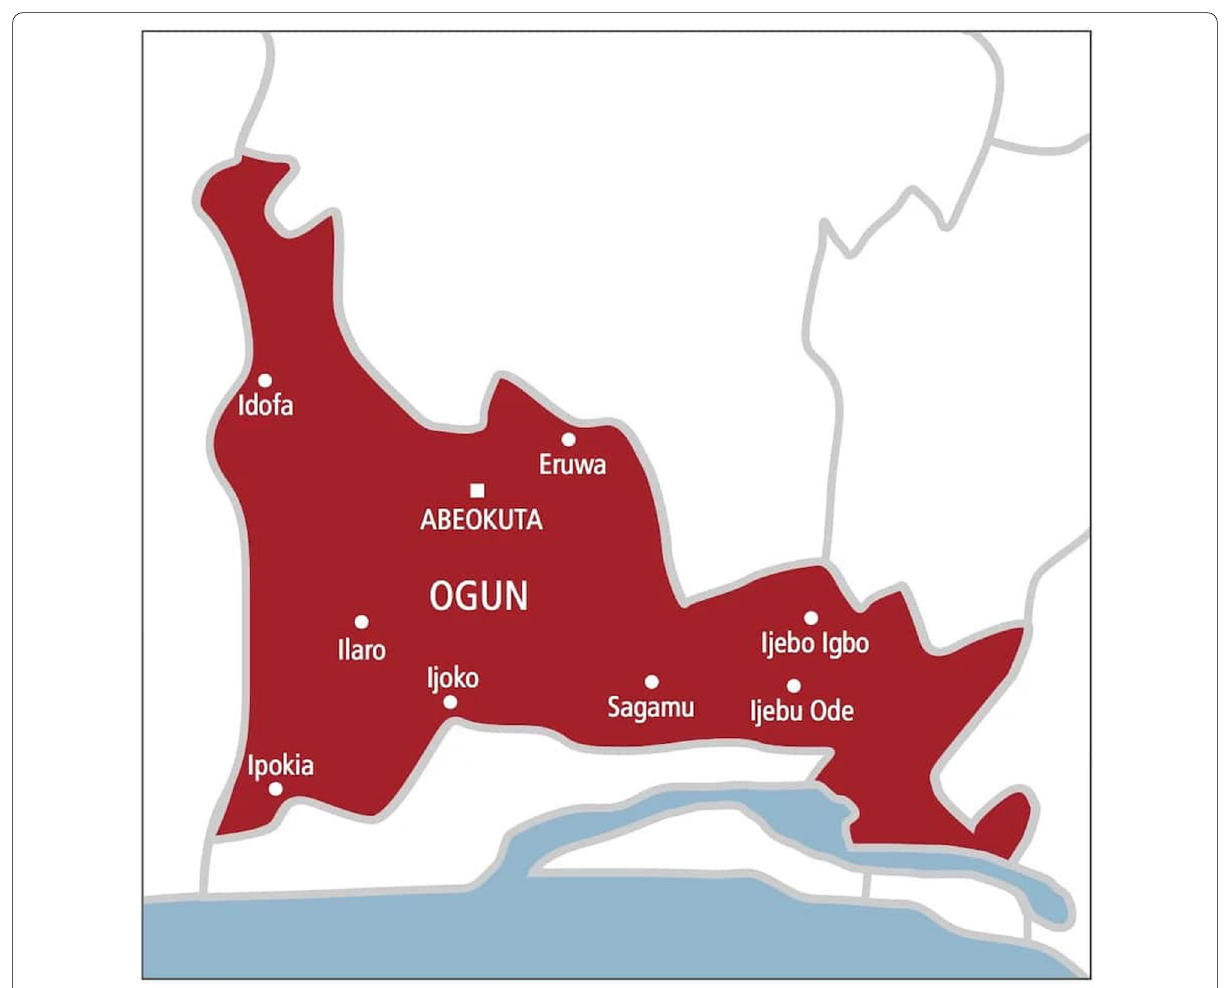
Fig. 1 Geographical location of Ogun state,